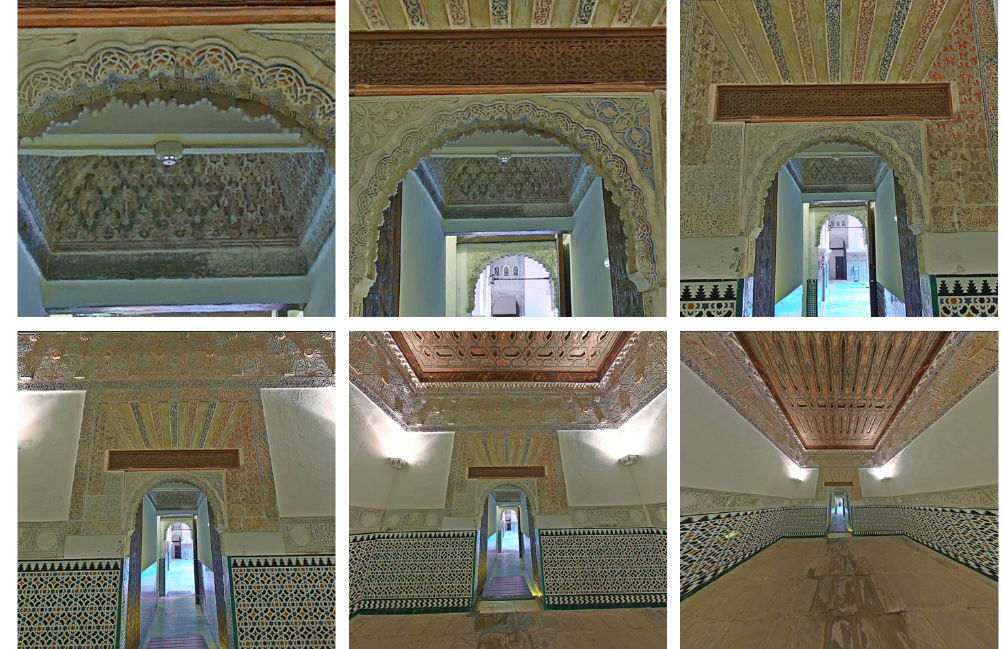
Figure 6. The same rectilinear projection extracted from a spherical image. The figure shows the effect of a variable